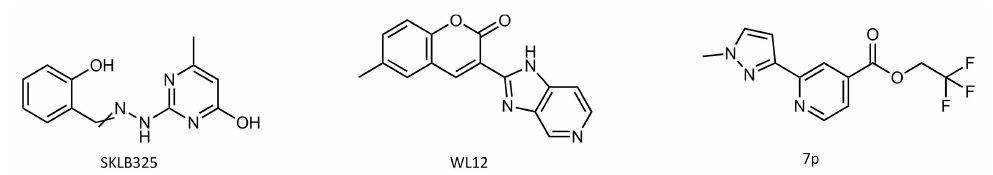
Figure 16. Chemical structure of the JMJD6